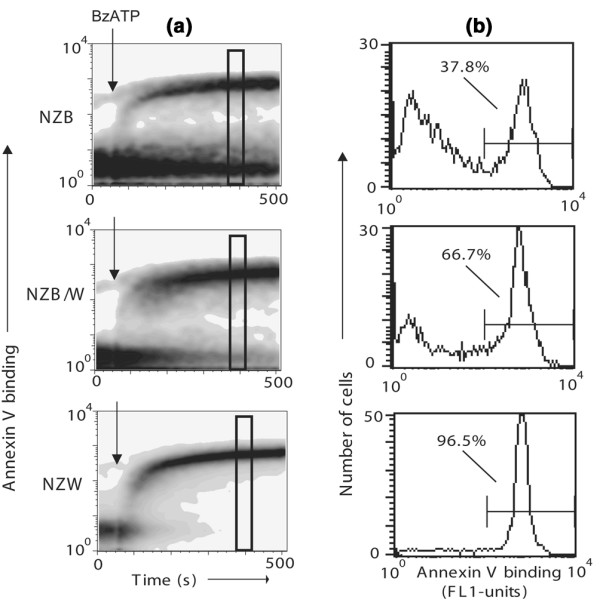
P2X7-stimulated phosphatidylserine (PS) exposure on lymphocytes. P2X7-dependent exposure of PS on New Zealand Black (NZB) lymphocytes, New Zealand White (NZW) lymphocytes and (NZB × NZW)F1 (NZB/W) lymphocytes. To enable the direct comparison of responses of cells from NZB mice, NZW mice and (NZB × NZW)F1 mice in a single tube, lymphocytes from these strains were stained with anti-CD4CYCHROME, anti-CD4PE and anti-CD4APC, respectively, mixed and equilibrated with annexin VFITC. Thus labelled, cells could subsequently be distinguished by flow cytometric gating. Cells were stimulated with the P2X7 agonist 2'-3'-O-(4-benzoylbenzoyl)-adenosine 5'-triphosphate (BzATP) at the time indicated by the arrow in (a). (a) Density plots of the rate of extracellular PS exposure in each cell population, as indicated by increased binding of annexin VFITC. (b) Corresponding percentage of cells bearing exposed PS in each population at a single timepoint (indicated by boxes in (a)).